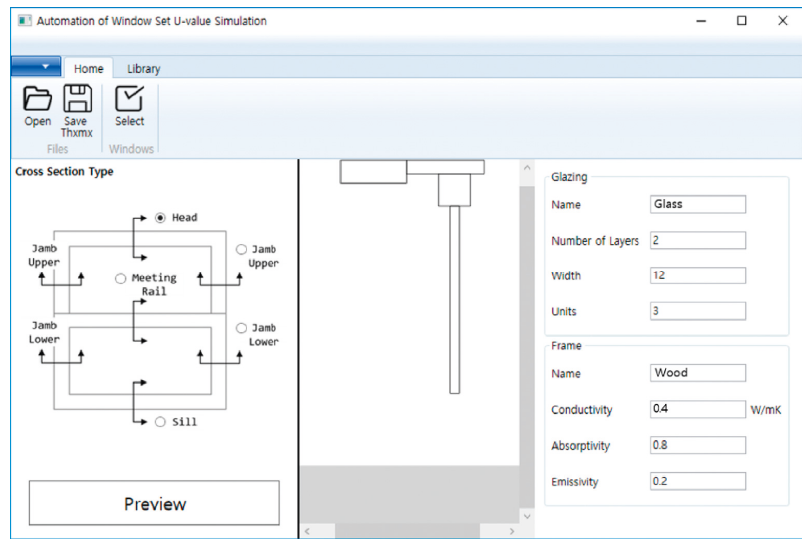
Figure 9: Conversion program input result of test case 1.